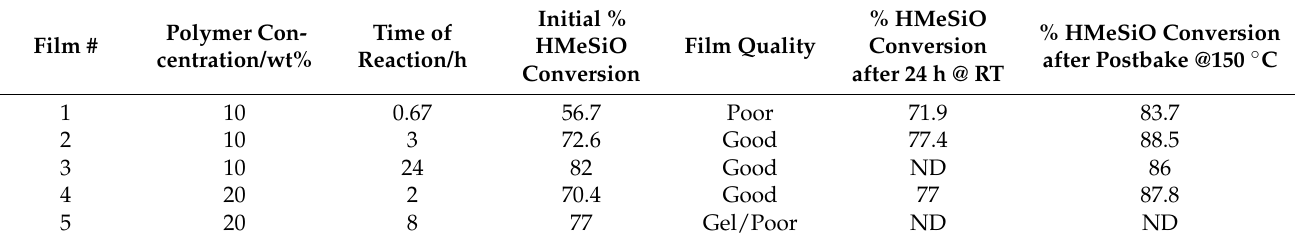
Table 3. Fabrication of thin films from restructured high-molecular-weight